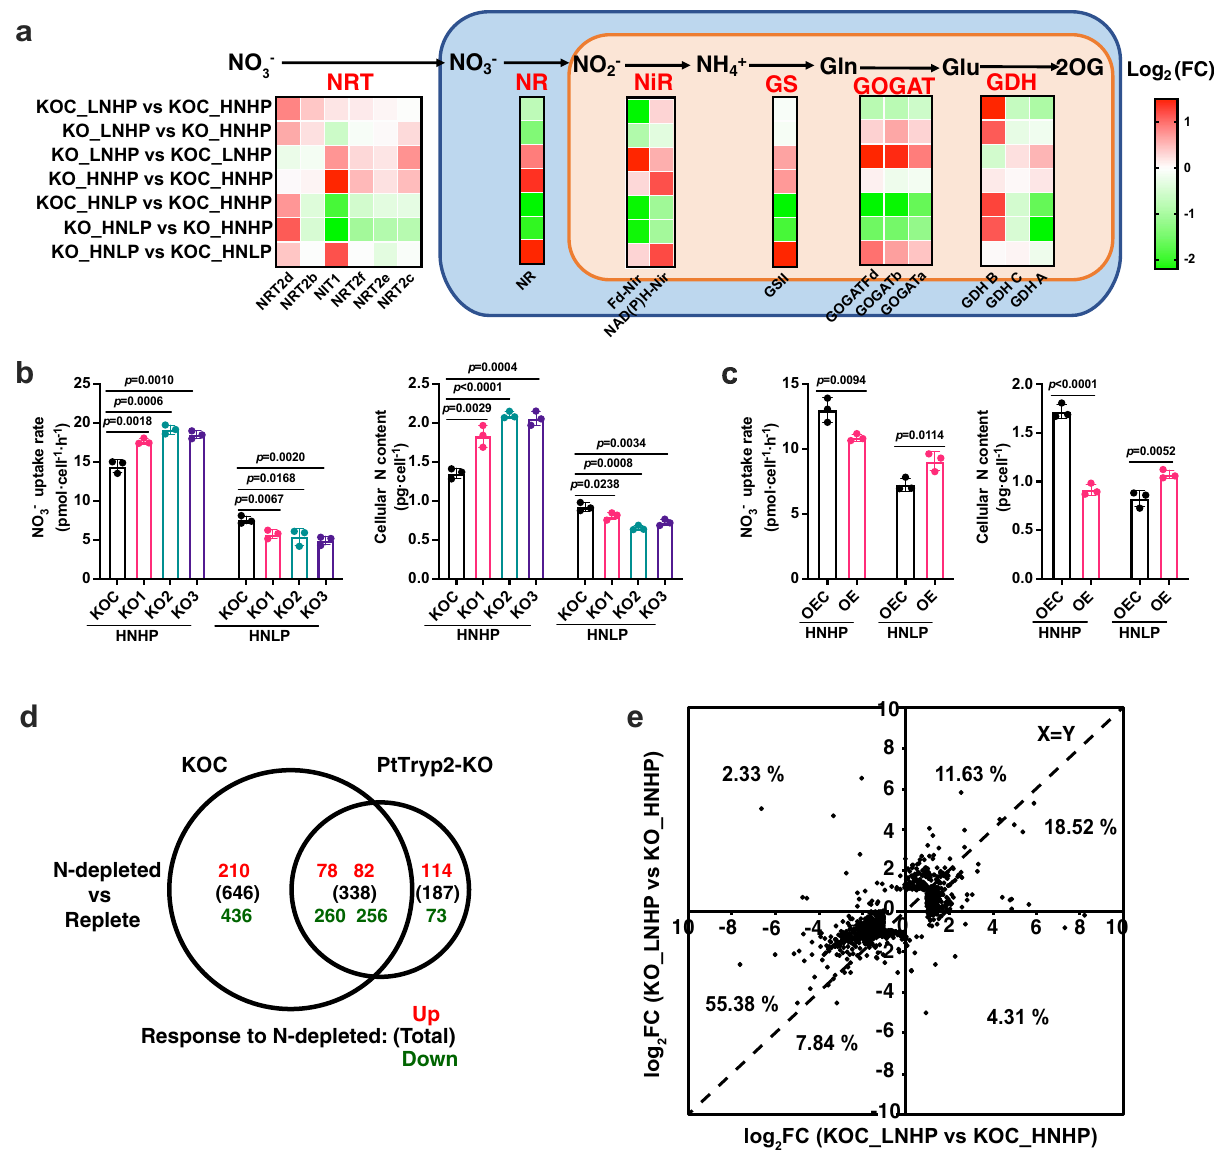
Fig. 5 Transcriptomic and physiological evidence that PtTryp2 directly represses nitrogen assimilation and metabolism. a PtTryp2 knockout resulted in upregulation of major nitrate-uptake and N-metabolism genes in PtTryp2 knockout (KO1) and control (KOC) under N-depleted (LNHP), P-depleted (HNLP), and nutrient-replete conditions (HNHP). NRT nitrate transporter, NR nitrate reductase, NiR nitrite reductase, GS glutamine synthetase, GOGAT glutamate synthase, GDH glutamate dehydrogenase, 2OG 2-Oxoglutarate; b NO 3 − uptake rate and cellular N content, increasing dramatically in PtTryp2 -KO under HNHP, but decreasing remarkably under HNLP. Data are presented as mean values± SD ( n = 3 biologically independent samples). The comparisons between the averages of the two groups were evaluated using the one-tailed Student ’ s t test. The p values with signi fi cance ( p ≤ 0.05) are shown. c NO 3 − uptake rate and cellular N content, decreasing remarkably in PtTryp2 -overexpressing P. tricornutum under HNHP, but increasing under HNLP. Data are presented as mean values ± SD ( n = 3 biologically independent samples). The comparisons between the averages of the two groups were evaluated using the one-tailed Student ’ s t test. The p values with signi fi cance ( p ≤ 0.05) are shown. d Venn diagram showing the number of N-depletion induced DEGs in PtTryp2 -KO1 and KOC. In parentheses, total number of DEGs; red font, upregulated; green font, downregulated. e Log 2 fold changes (FC) of N-depletion induced differential gene expression in PtTryp2 -KO1 against that in KOC. Most data points (93.37%) are distributed in 1,3 quadrants, indicating the same direction of change. Source data are provided as a Source Data fi